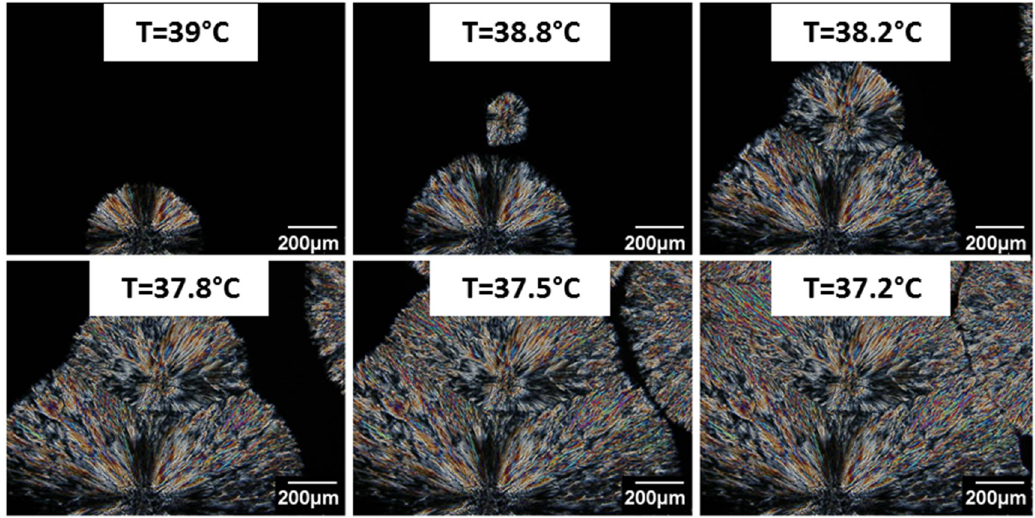
Figure 4. PEG spherulite crystallization observed by optical microscopy in combination with polar- ized light during a cooling ramp.